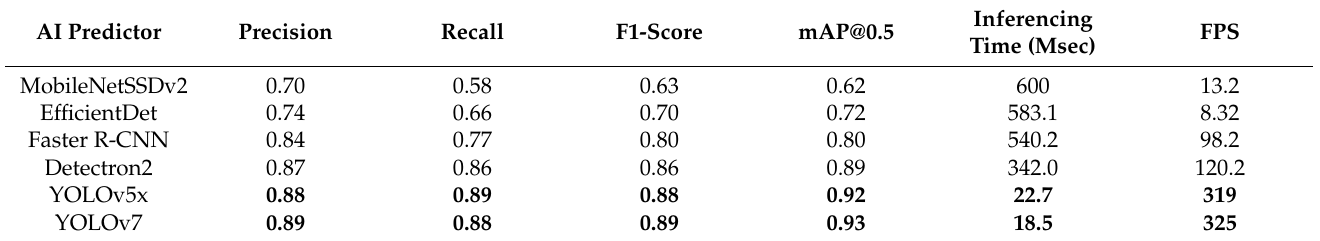
Table 3. Direct evaluation prediction performance of the proposed VPP framework using